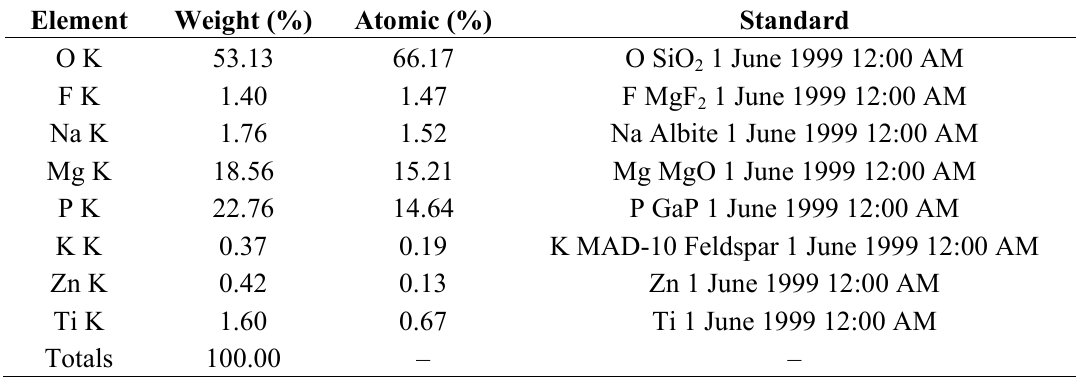
Table 1. The data of the spectrum detection for the PEO coating (number of iterations = 3). Element Weight (%) Atomic (%) Standard O